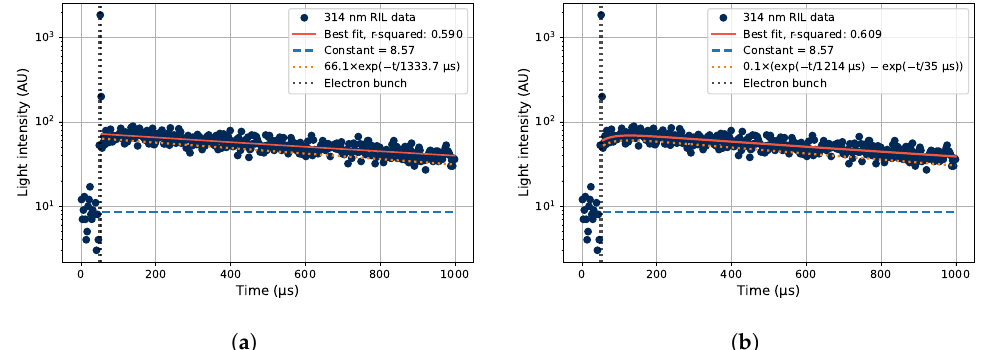
Figure 9. Measured decay curves of the 314 nm RIL of the Gd 3 + -doped sample, using 12 MeV electrons at a depth of 2 cm in acrylic. The time of the electron pulse is also shown. ( a ) Data fitted to one exponential decay component (orange dotted line) plus a constant representing the background level (blue dashed line), according to Equation (2). ( b ) The data fitted with one exponential decay component with an additional term to account for the initial increase in light emission intensity over time shortly after the electron bunch, described in Equation